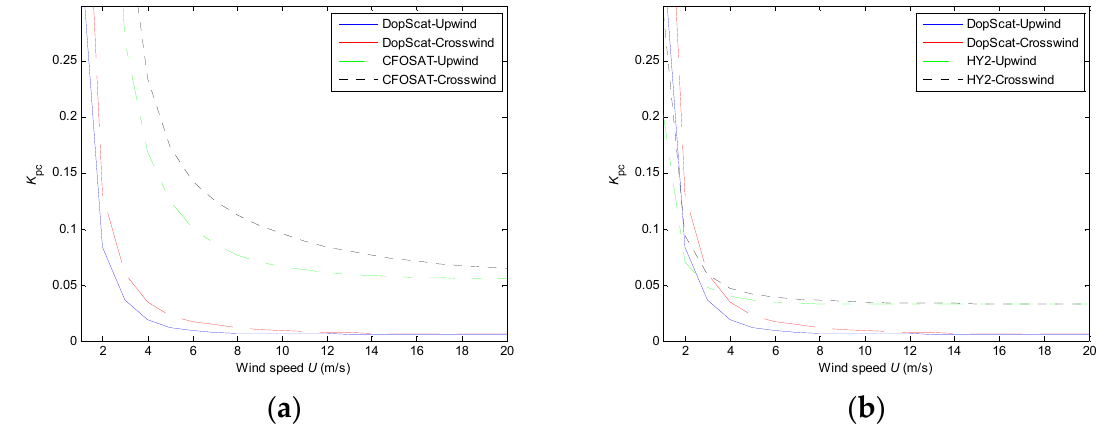
Figure 18. The value of K pc with different wind speeds: ( a ) comparison of K pc between DopScat and a traditional fan-beam scatterometer; ( b ) comparison of K pc between DopScat and a traditional pencil-beam scatterometer.